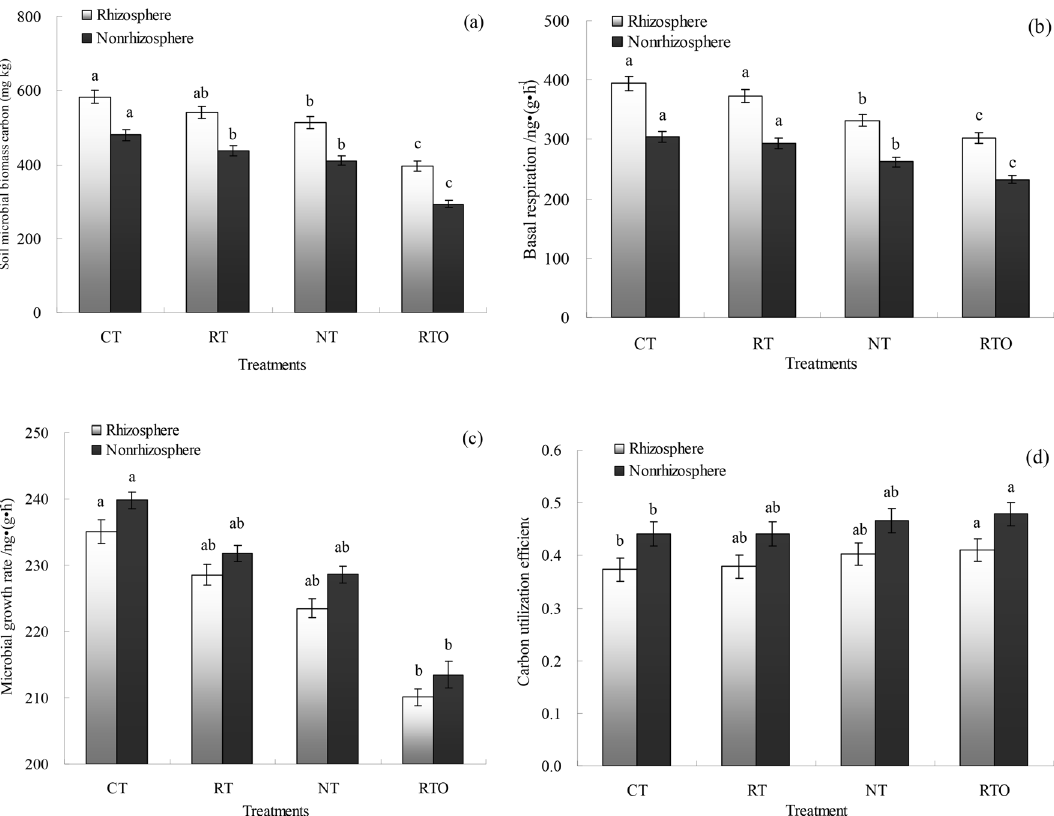
Figure 2. Soil microbial distribution in rhizosphere and non-rhizosphere soils with different tillage treatments. ( a ) Soil microbial biomass carbon. ( b ) Basal respiration of soil microorganism. ( c ) Soil microbial growth rate. ( d ) Soil microbial carbon utilization efficiency. CT conventional tillage with crop residue incorporation, RT rotary tillage with crop residue incorporation, NT no-tillage with crop residue retention, RTO rotary tillage with crop residue removed as control. Error bars were represented standard error of mean. Different smaller letters were indicated significantly difference at P < 0.05